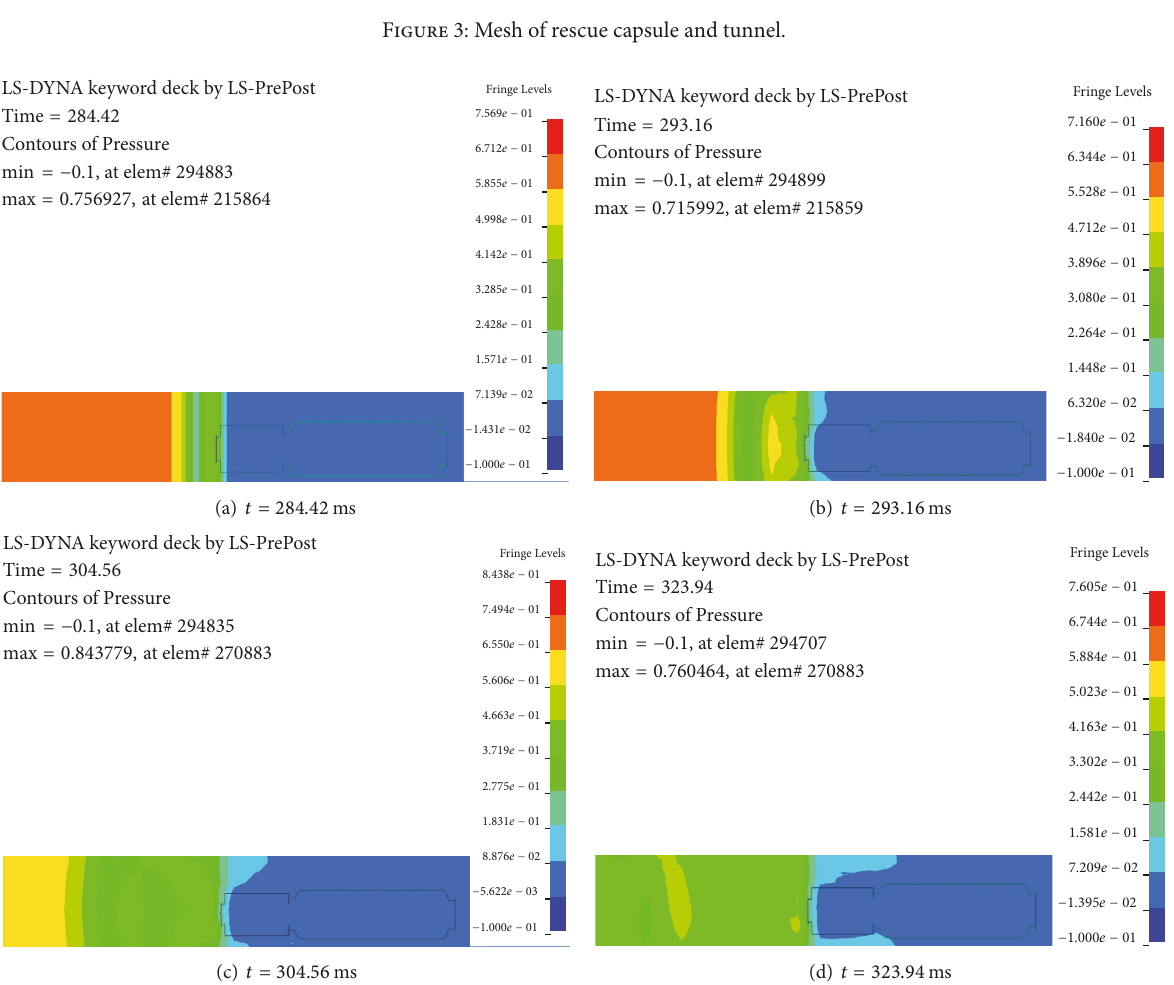
Figure 4: Pressure contour of the blast wave interaction with the rescue capsule in the